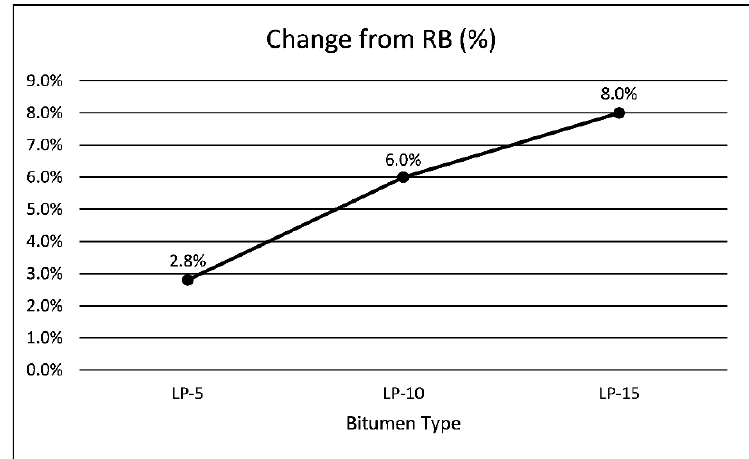
Figure 13. Change of softening point with respect to reference bitumen.